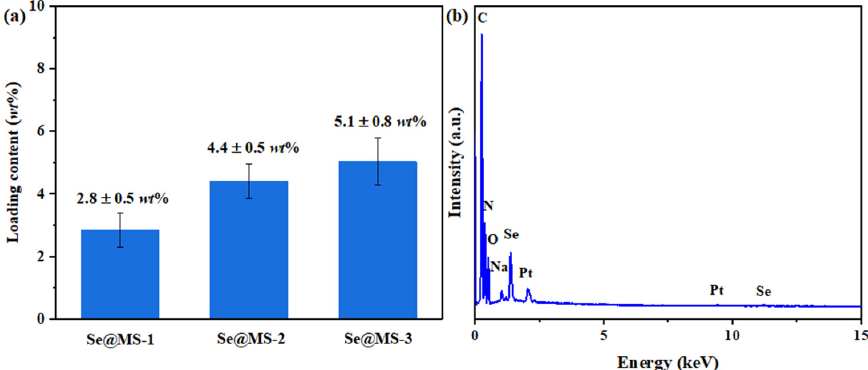
Figure 2. The analysis of Se content in the as-fabricated Se@MS. ( a ) Weight percentage analysis of Se content in the Se@MS-1, Se@MS-2, and Se@MS-3, and ( b ) element content of the Se@MS-2 measured by EDS.